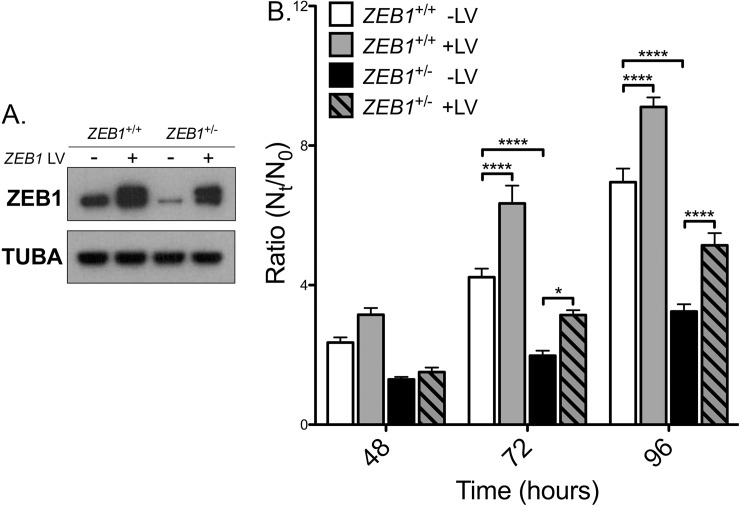
ZEB1 reduction impairs CEnC proliferation capacity.(A) Western blotting results showing ZEB1 levels in each of the CEnC lines following transient ZEB1 overexpression with lentivirus (5 days post-transduction). Alpha-tubulin (TUBA) was used as a loading control. (B) Bar graph showing cell proliferation graphed as the ratio of cell number at time t (Nt) over cell number at 3 hours (N0), Nt/N0. Ratios were calculated at 48, 72 and 96 hours post-seeding. Data were represented as the mean ±SEM (n = 6). Comparisons were performed using two-way ANOVA (genotype and time) with post-hoc Bonferroni test. *, P<0.05; ****, P<0.0001.